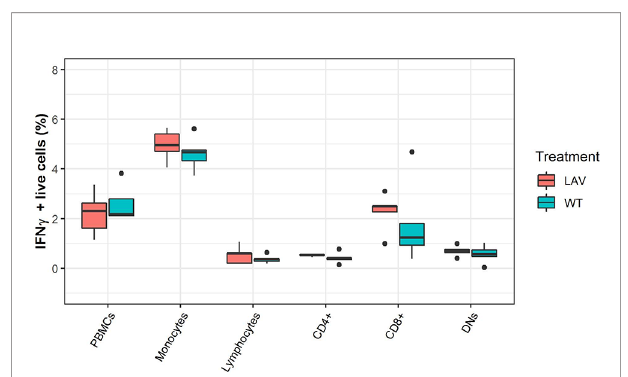
FIGURE 5 | Active viral replication in PBMC and CD14- cells. DNAse treated RNA was used a template for absolute quati fi cation of the RPO30 gene. Viral copies were calculated and the mean (n=5) plotted as box plots with GraphPad Prism 9. Analysis was performed using